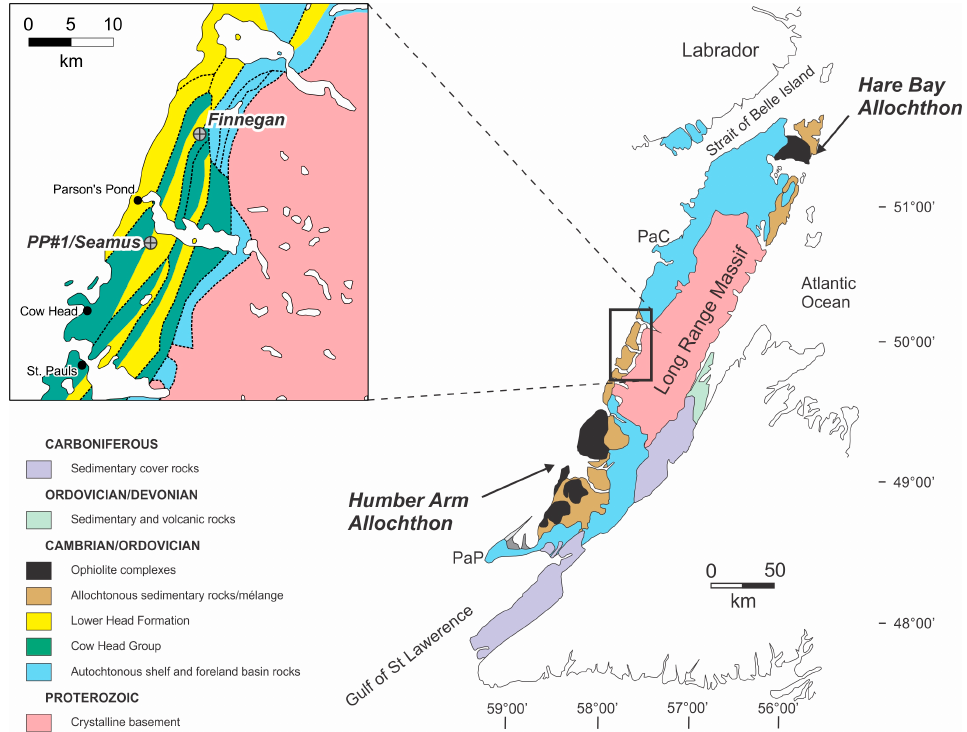
Figure 1. Simplified map of the geology of western Newfoundland, showing the location of Parsons Pond, adapted from [3]. Inset map showing detailed geology of Parsons Pond area, with locations of exploration wells, adapted from [4].